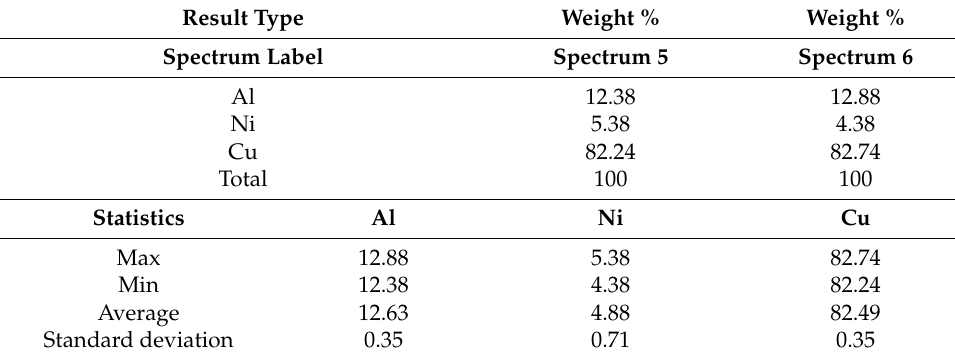
Table 3. EDS analysis after quenching (K2).